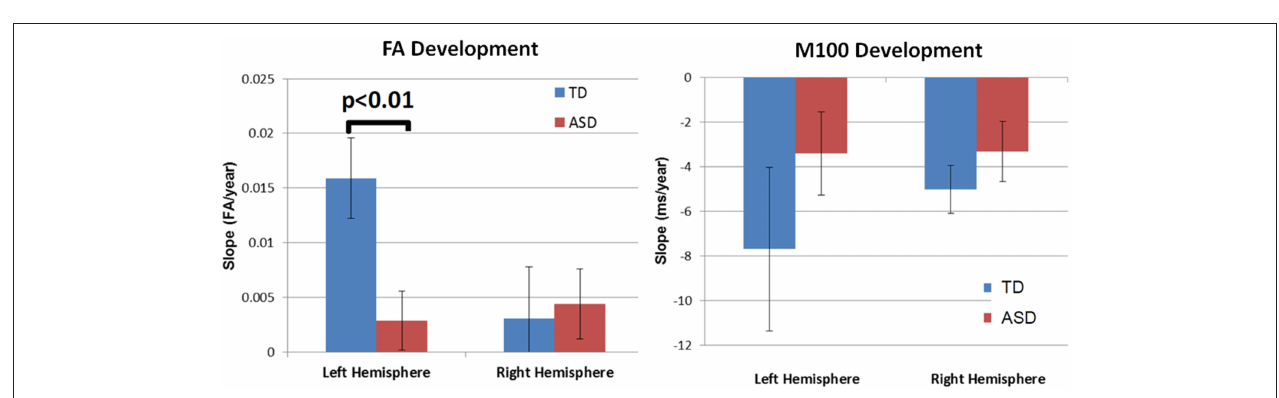
FIGURE 4 | Developmental trajectory (slope) of auditory radiation FA (left) and auditory cortex M100 latency (right). Left-hemisphere FA development was significantly slower in ASD vs. TD ( p < 0.01 ). Although not reaching significance, the left-hemisphere M100 latency showed a similar pattern of more rapid development in TD vs. ASD. For both MEG and DTI measures, a lack of hemispheric asymmetry or specialization is evident in the ASD group.